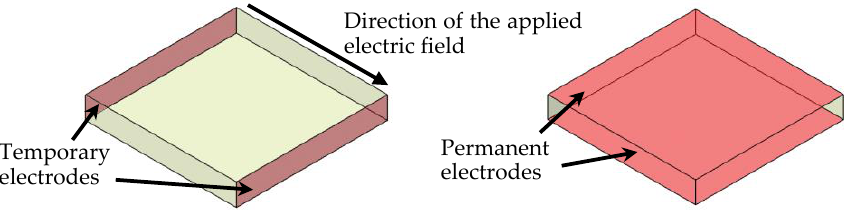
Figure 3. Temporary and permanent electrodes for the shear sensors.